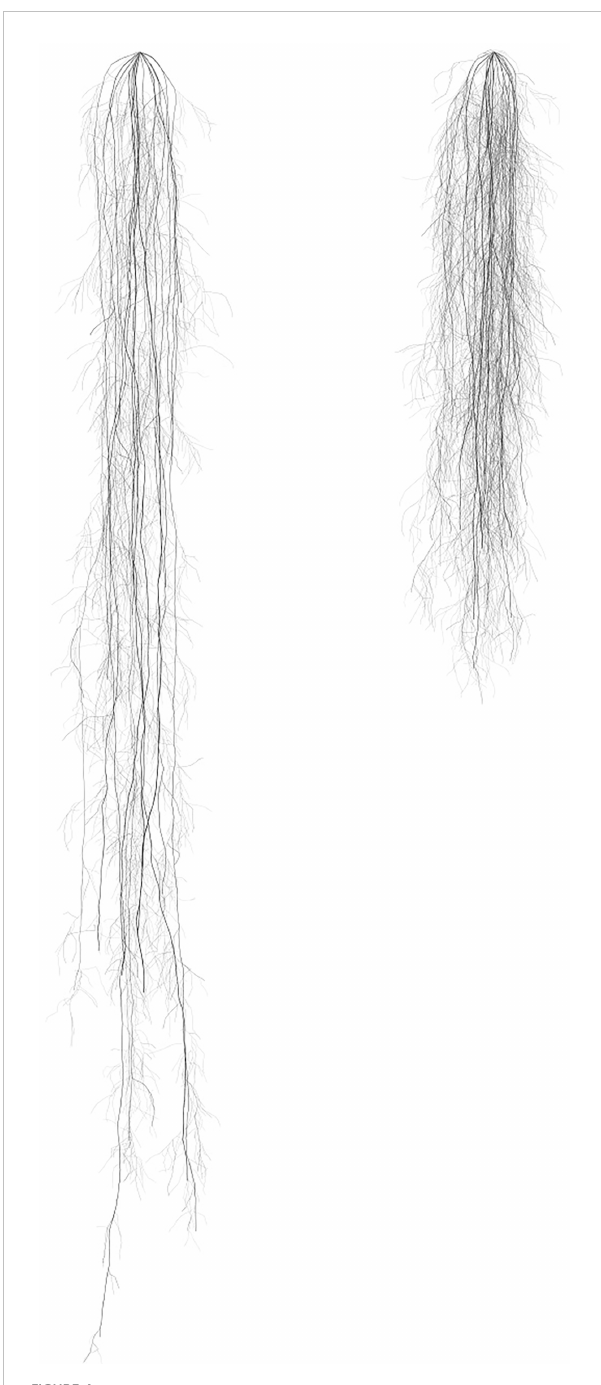
FIGURE 4 A rendering of 3D root structure modeled by CropRootBox.jl using the growth parameters obtained from roots growing with high water availability (left) and roots growing with nutrient availability (right) in the resource-partitioned